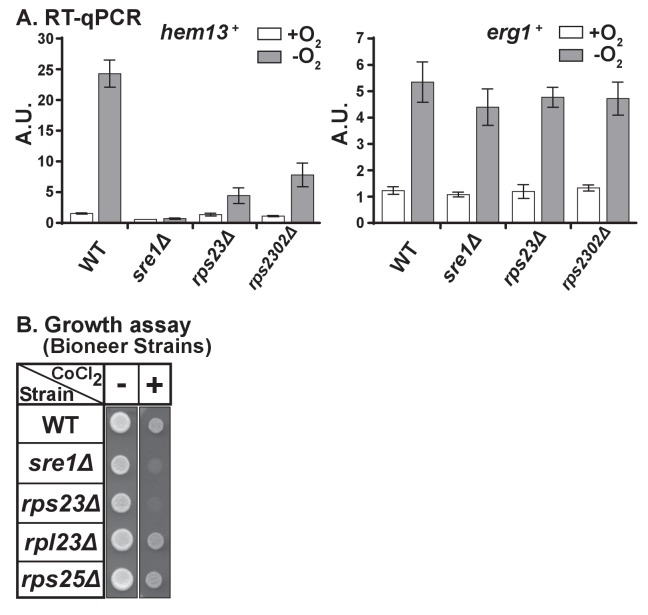
Unassembled Rps23 regulates Ofd1 inhibition of Sre1N.(A) RNA was harvested from wild-type, sre1Δ, rps23Δ, and rps2302Δ cells grown in the presence or absence of oxygen for 3 hr. Extracted total RNA was analyzed by RT-qPCR for expression of Sre1 target hem13+ (left) and non-Sre1 target erg1+ (right). Error bars represent ± SEM of fold changes from three biological replicates with each biological replicate consisting of two technical replicates. Each biological replicate was an independent experiment. (B) Indicated strains from Bioneer haploid deletion collection were grown (5000 cells/spot) on rich medium (3 days) and rich medium containing 1.6 mM cobalt chloride (CoCl2) (6 days). Shown are representative images from one of two independent experiments.